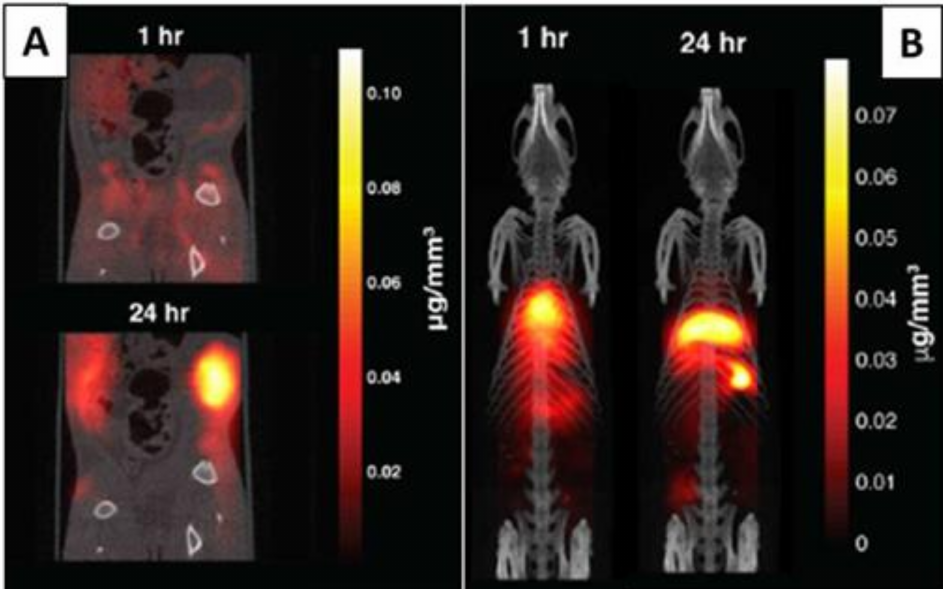
Figure 16. ( A ) Tracer dynamics in group A rats. Slices through the MPI volume over time are co-registered to corresponding CT slices. The MPI images show the SPIONs’ dynamics, from initial rim enhancement and accumulation until the maximum signal. ( B ) Tracer dynamics in group B rats. Maximum intensity projection of 3D MPI volumes co-registered with CT skeletal reference. Adapted with permission from [117], Copyright 2017 American Chemical